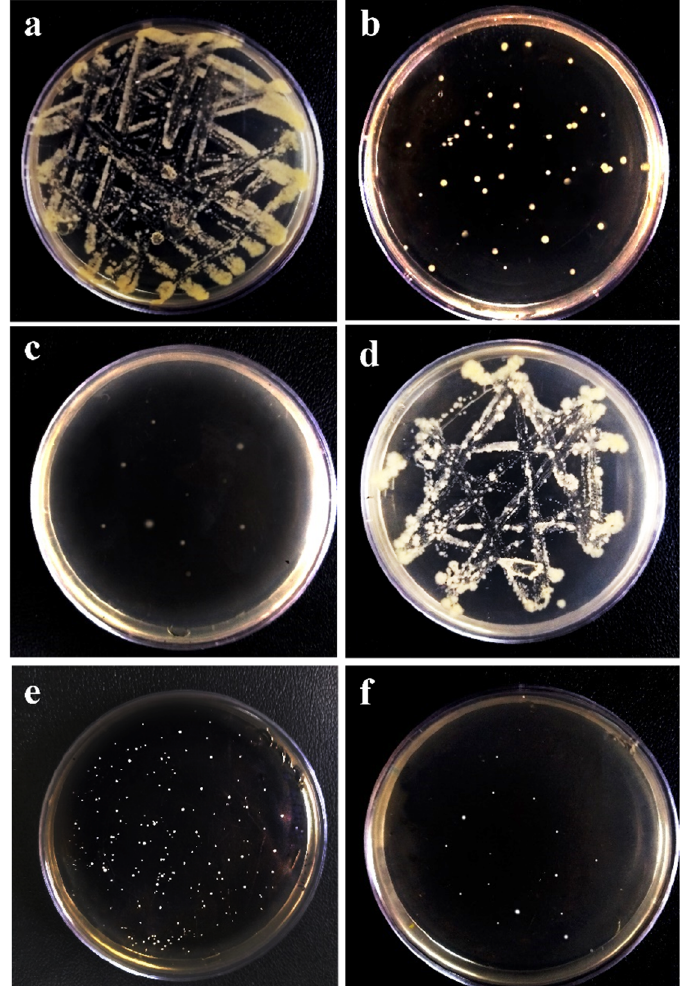
Figure 10. The colony culture results of different samples: ( a ): Negative control for E. coli (Bacteria and culture media without any textiles), ( b ): PLA/Gel on E. coli , ( c ): PLA/Gel/SNPs on E. coli , ( d ): Negative control for S. aureus (Bacteria and culture media without any textiles), ( e ): PLA/Gel on S. aureus , ( f ): PLA/Gel/SNPs on S. aureus .